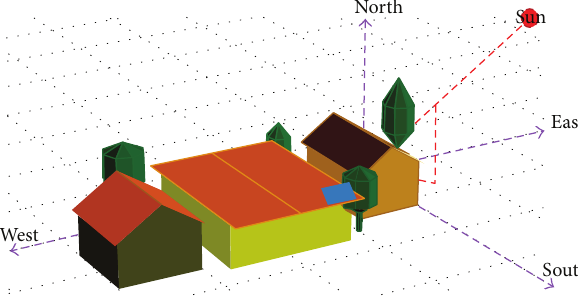
Figure 8: South facing PV array and its environment in Banjul.